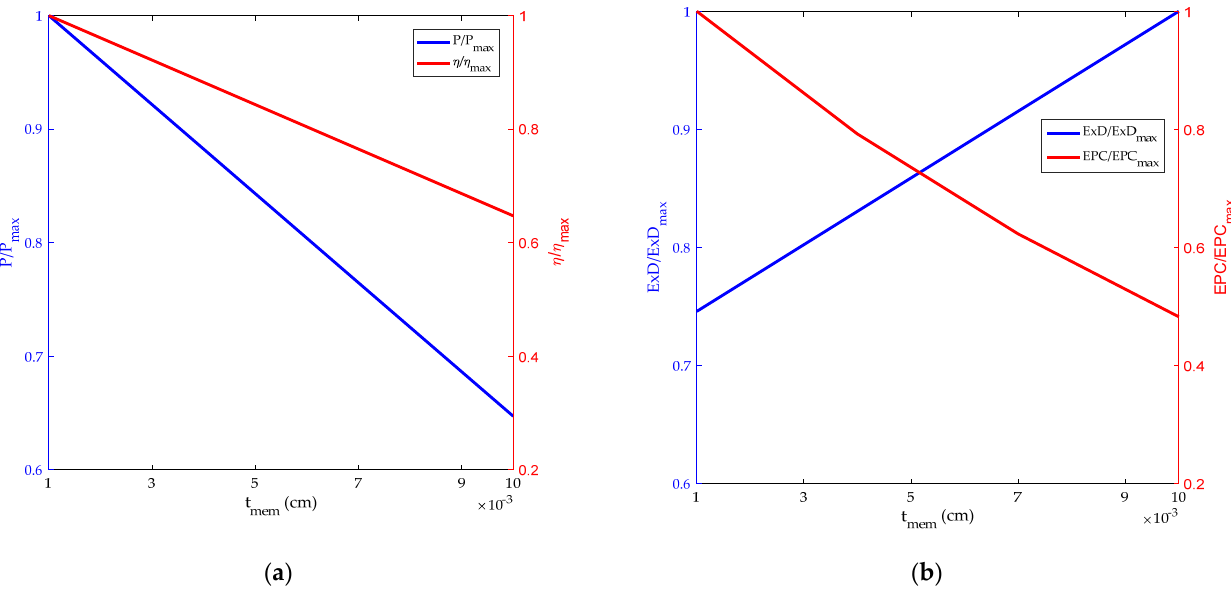
Figure 9. Influence of film thickness. ( a ) Power density and energy efficiency; ( b ) exergy destruction rate and exergetic performance coefficient.